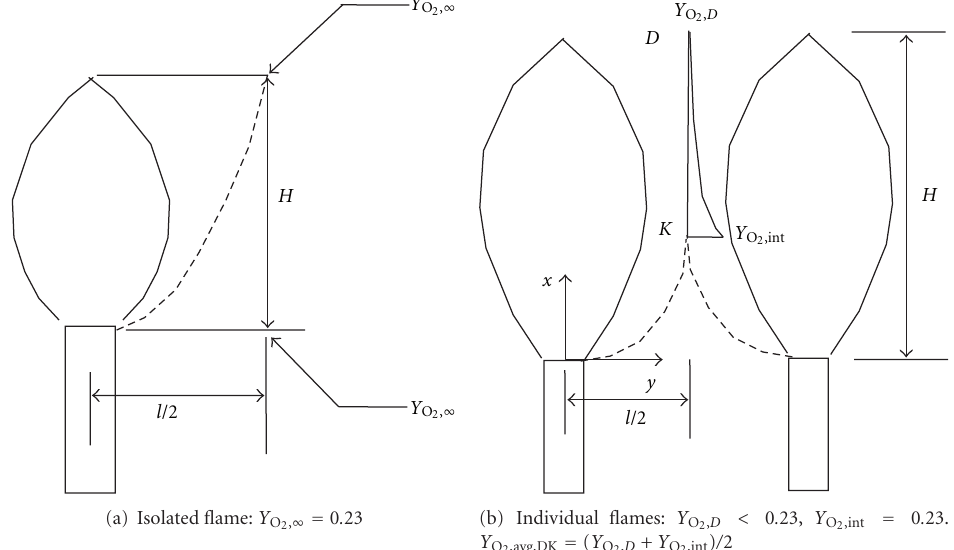
Figure 9: Oxygen profiles for (a) single flames and (b) multiple